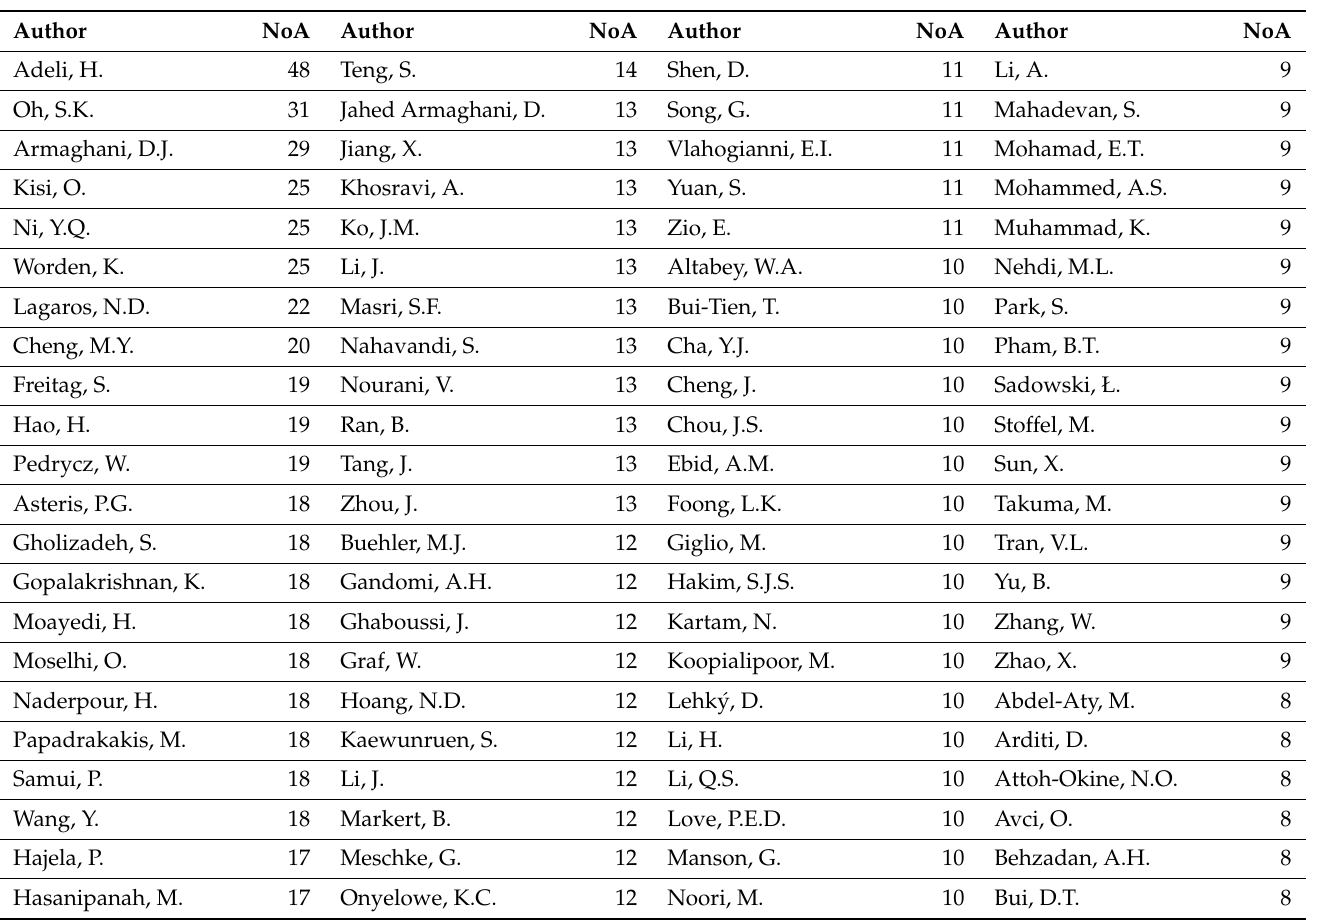
Table 1. The authors with most journal articles related to “Artificial neural networks applied in civil engineering”, in Scopus (until 26 December